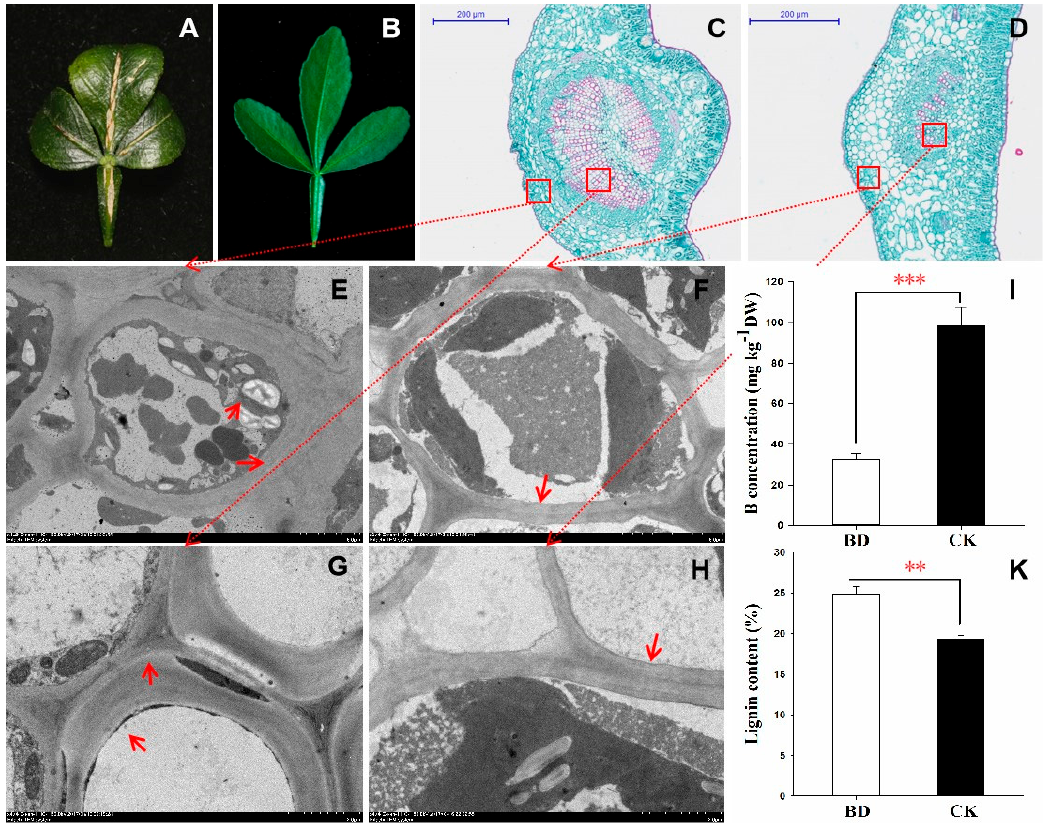
Figure 1. The different performance of trifoliate orange seedlings under boron deficient stress for 12 weeks. Two-month-old plants were grown in hydroponics and treated for another 12 weeks. Morphological performance of BD ( A ) and CK ( B ) leaf; Paraffin slice micrograph of the malformed vein in BD ( C ) and CK ( D ); Electron microscope observation in the cell and vessel of BD ( E,G ) and CK ( F , H ); Boron concentration ( I ) and the lignin content ( K ) in the leaf of trifoliate orange; Significant level ** p < 0.01,*** p < 0.001. Bars = 200 µ m in ( C , D ), 10 µ m in ( E , F ), and 2 µ m in ( G , H ). BD: Boron deficiency; CK: Control.